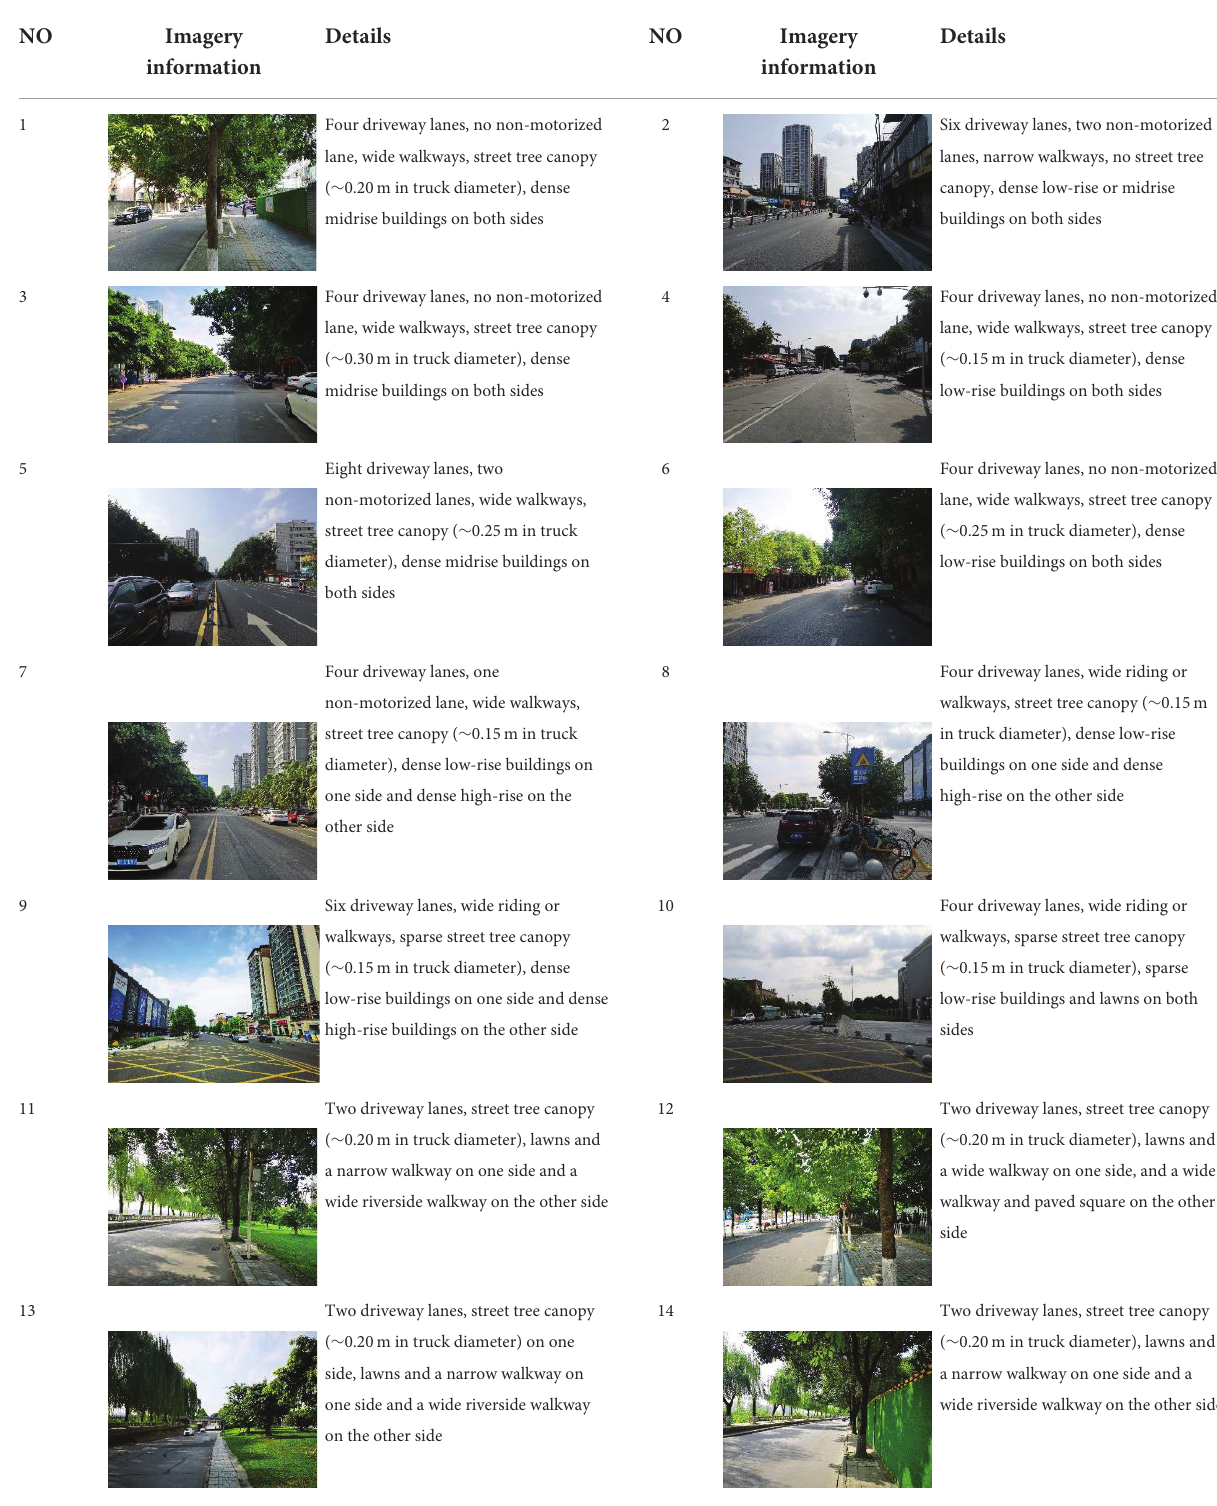
TABLE 2 Morphological characteristics of 40 street